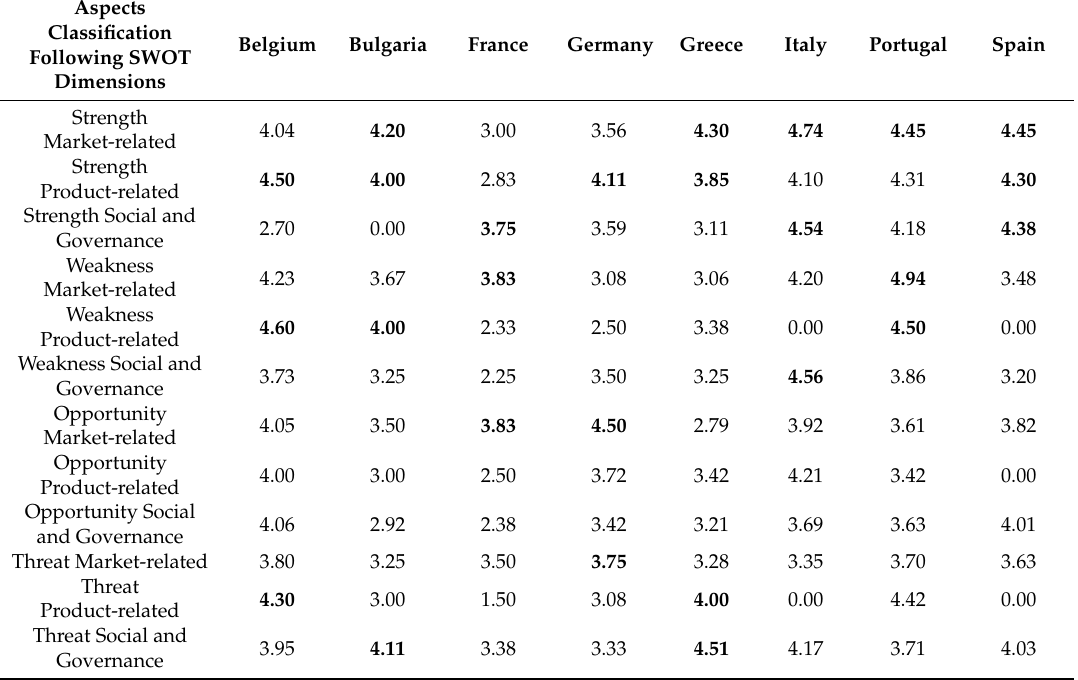
Table 2. Country average value for each for category for SWOT